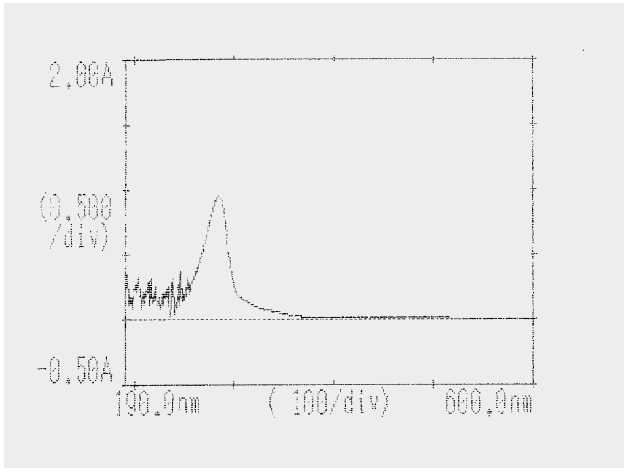
Figure 1: UV-VIS spectra of m-CHF-I.